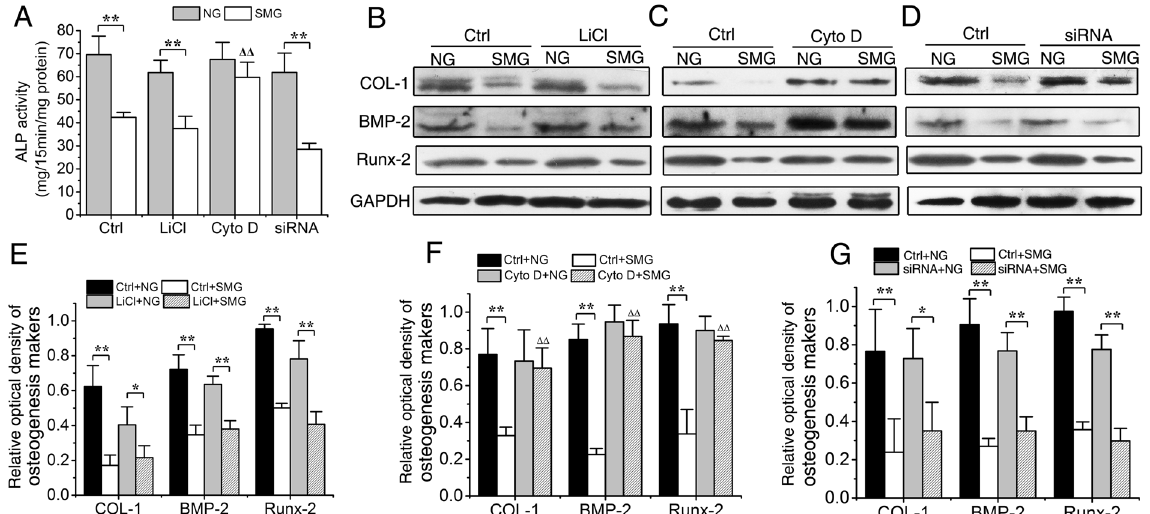
Figure 6. Elongation of cilia promotes the osteoblastic differentiation of rat calvarial osteoblasts (ROBs) in microgravity condition. ( A ) Alkaline phosphatase (ALP) activities of ROBs in Ctrl group, LiCl group, cytochalasin D (Cyto D) group or dynein light chain Tctex-type 1 (Dynlt1) siRNA group with or without random positioning machine (RPM) microgravity exposure. ( B ) Representative Western blot detecting expression of osteogenesis markers COL-I, BMP-2 and Runx-2 (with GAPDH as a control) in each group. ( C ) The protein levels of COL-I, BMP-2 and Runx-2 in each group. NG: normal ground, SMG: simulated microgravity. Full-length Western blots are presented in Supplementary Figure 5. Each experiment was conducted at least three times independently. * P < 0.05 or ** P < 0.01 vs NG group of each treatment; △△ P < 0.01 vs Ctrl of SMG